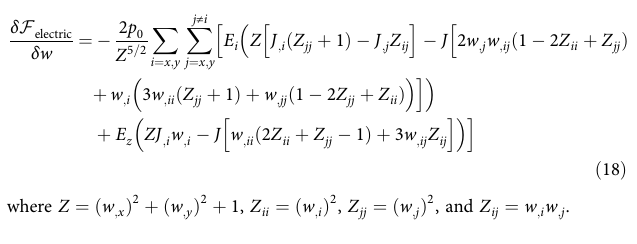
Λ for MoSeS. All DFT calculations were performed with the Vienna mix ð c ± Þ and Ab Initio Simulation Package (VASP) 82,83 using a plane-wave basis set and the projector augmented wave method 84,85 . The Perdew-Burke-Ernzerhof generalized gradient approximation was employed to treat exchange-correlation effects 86 . The plane wave kinetic energy cutoff was set to 420 eV, and a 12 ´ 12 ´ 1 Γ -centered k- point grid was employed for Brillouin zone integration. All atomic structures were fully relaxed until the total force on each atom was < 0 : 01 eV Å (cid:2) 1 . A vacuum layer of minimum thickness 20 Å perpendicular to the monolayer was employed to minimize interactions between the monolayer and its periodic images. The total energies of MX 2 and MY 2 ( U X and U Y ) appearing in the enthalpy of mixing were directly computed (Supplementary Table 1). Their derivatives at (cid:1) c ¼ 0 and 1 were evaluated from the change in total energy density upon substituting one Se (S) atom into large supercells containing 150 atoms (5 ´ 5 conventional unit cells). Results of these calculations are shown in Supplementary Fig. 2a. We obtained dU = d (cid:1) c j (cid:1) c ¼ 0 ¼ ð U (cid:1) c ¼ 0 : 01 (cid:2) U (cid:1) c ¼ 0 Þ = 0 : 01 ¼ 1 : 666eV per Mo and dU = d (cid:1) c j (cid:1) c ¼ 1 ¼ ð U (cid:1) c ¼ 1 (cid:2) U (cid:1) c ¼ 0 : 99 Þ = 0 : 01 ¼ 1 : 951eV per Mo. Using these values, we determined the regular solution parameter; χ ¼ ð dU = d (cid:1) c j = d (cid:1) c j = 2 ¼ (cid:2) 0 : 1425 eV per Mo. (cid:1) c ¼ 0 (cid:2) dU (cid:1) c ¼ 1 Þ The constant that describes the compositional interactions between chalcogen layers, Λ , was determined by considering monolayers with only S atoms in one chalcogen layer and random mixtures of S and Se atoms at different average compositions in the other chalcogen layer. Λ was quanti fi ed from the difference in total energy between such asymmetric monolayers U a and symmetric monolayers with equal compositions in both chalcogen layers U s . We fi t these data to a quadratic form U a (cid:2) U s (cid:4) ð U a 2 (cid:2) U s 2 Þð (cid:1) c þ (cid:2) (cid:1) c (cid:2) Þ 2 (see Supplementary Fig. 2b). Comparison with Eq. (5) shows that Λ ¼ 2 ð U a 2 (cid:2) U s 2 Þ (cid:4) 0 : 13 eV per Mo-atom. Mechanical and chemical relaxation . Out-of-plane displacements are evolved toward equilibrium using a physically-motivated damped wave equation that approximates fl exural acoustic phonons (cid:9) ð 19 Þ w ; tt þ β 0 (cid:2) β 1 ∇ 2 β β 0 and 1 are damping parameters that operate uniformly and preferentially on large wavenumber oscillations, respectively, and α w is the propagation speed of bending waves. For conditions in which chalcogen composition is not conserved, c þ and c (cid:2) are dissipatively relaxed to equilibrium ð 20 Þ Here, M ± is the diffusional mobility of chalcogens and λ 0 is the environmental chemical potential. This choice assumes substitutional diffusion between species X and Y ( M X ¼ M Y ¼ M ± ). For conditions in which chalcogen composition is conserved but only equilibrium states are of interest (physical kinetics are not necessary), a Lagrange multiplier is added to enforce conservation without the need for slower diffusive kinetics ð 21 Þ R ð δ F = δ c ± Þ d r is the Lagrange multiplier that enforces global Here, λ ± ¼ A (cid:2) 1 A conservation of species in each XY -layer.